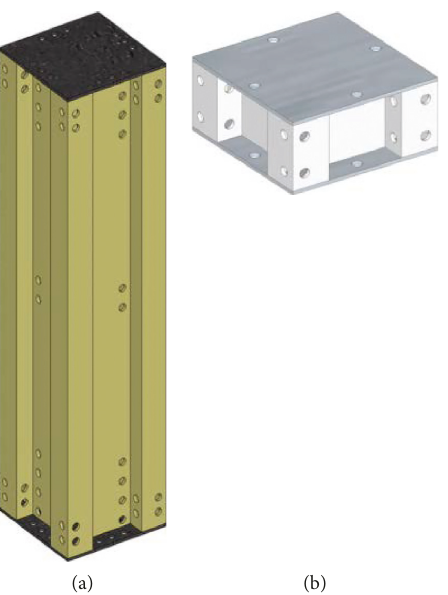
Figure 5: Structural generating couple. (a) Basic unit BU1, length 480mm; (b) basic unit BU2, length 60mm.